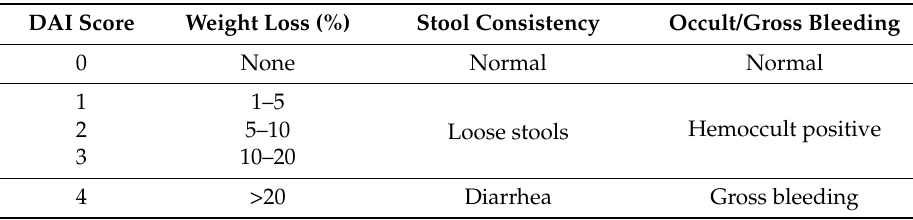
Table 3. Evaluation of disease activity index